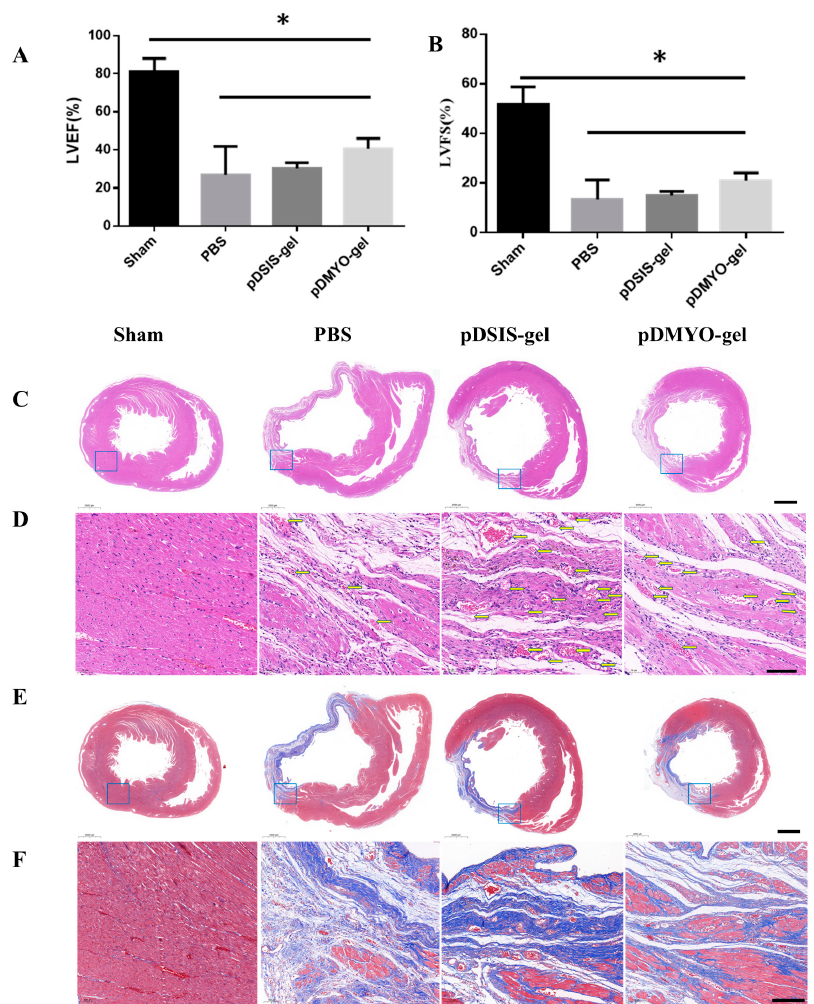
Figure 5. Effect of decellularized matrix hydrogels on acute myocardial infarction in rats ( A ) the effect of decellularized matrix hydrogels on left ventricular ejection fraction (LVEF). ( B ) the effect of decellularized matrix hydrogels on left ventricular shortening fraction (LVFS). ( C ) The H&E staining images of the rat heart sections (0.7 times magnification, the scale bar is 2000 µ m); ( D ) The local magnified H&E-stained images of the infarct border area (18 times magnification, the magnified area is the blue box area in Figure 5C; the yellow arrow marks the location of the vessel; the scale bar is 100 µ m); ( E ) the Masson staining images of the rat heart sections (0.7 times magnification, the scale bar is 2000 µ m); ( F ) the local magnified Masson-stained images of the infarct border area (10 times magnification, the magnified area is the blue box area in Figure 5E. The collagen fibers were blue color, while the myocardial fibers were red color and the cell nuclei were blue black. The scale bar is 200 µ m). * denotes statistical difference within the same group with p < 0.05, respectively ( n =